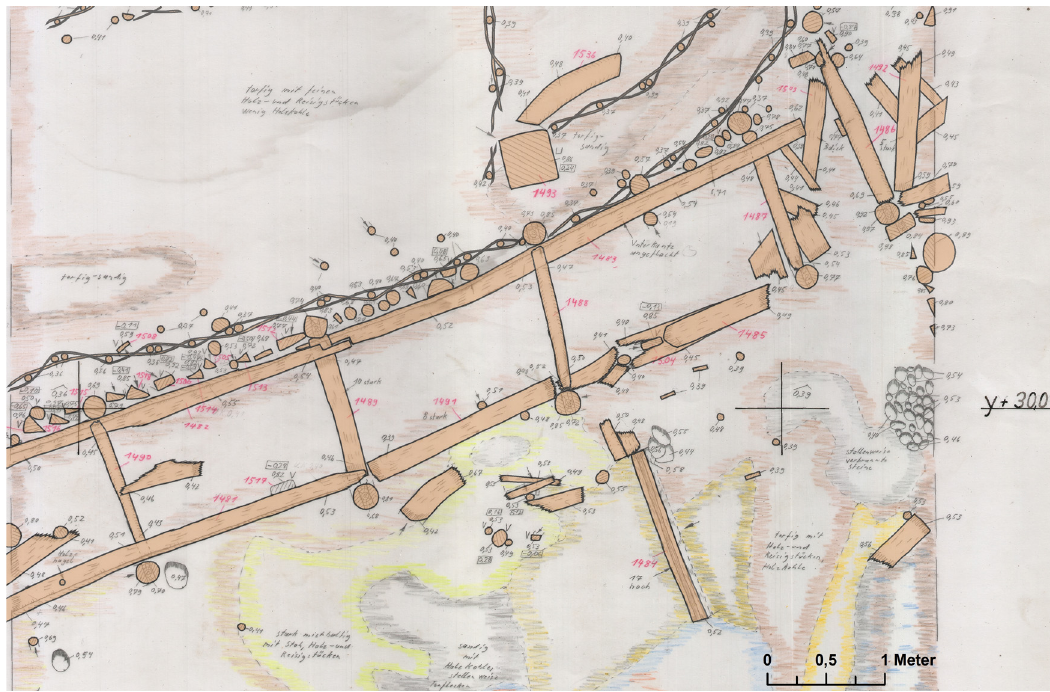
Figure 6: Executing step 10: planum drawing from trench 9 with polygon layer of the wooden features on top ( Graphics: F. Rösch )